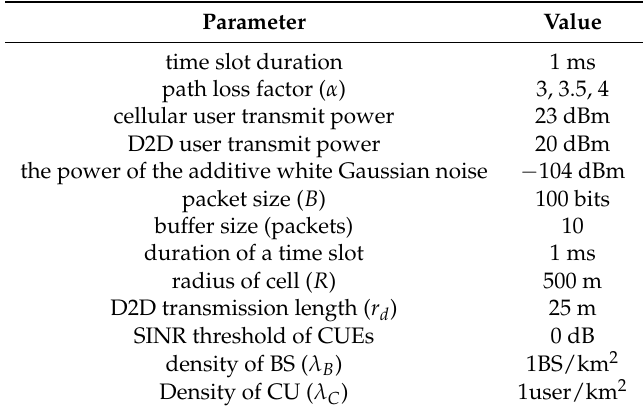
Table 1. Simulation parameters of Monte Carlo simulation. CU, cellular